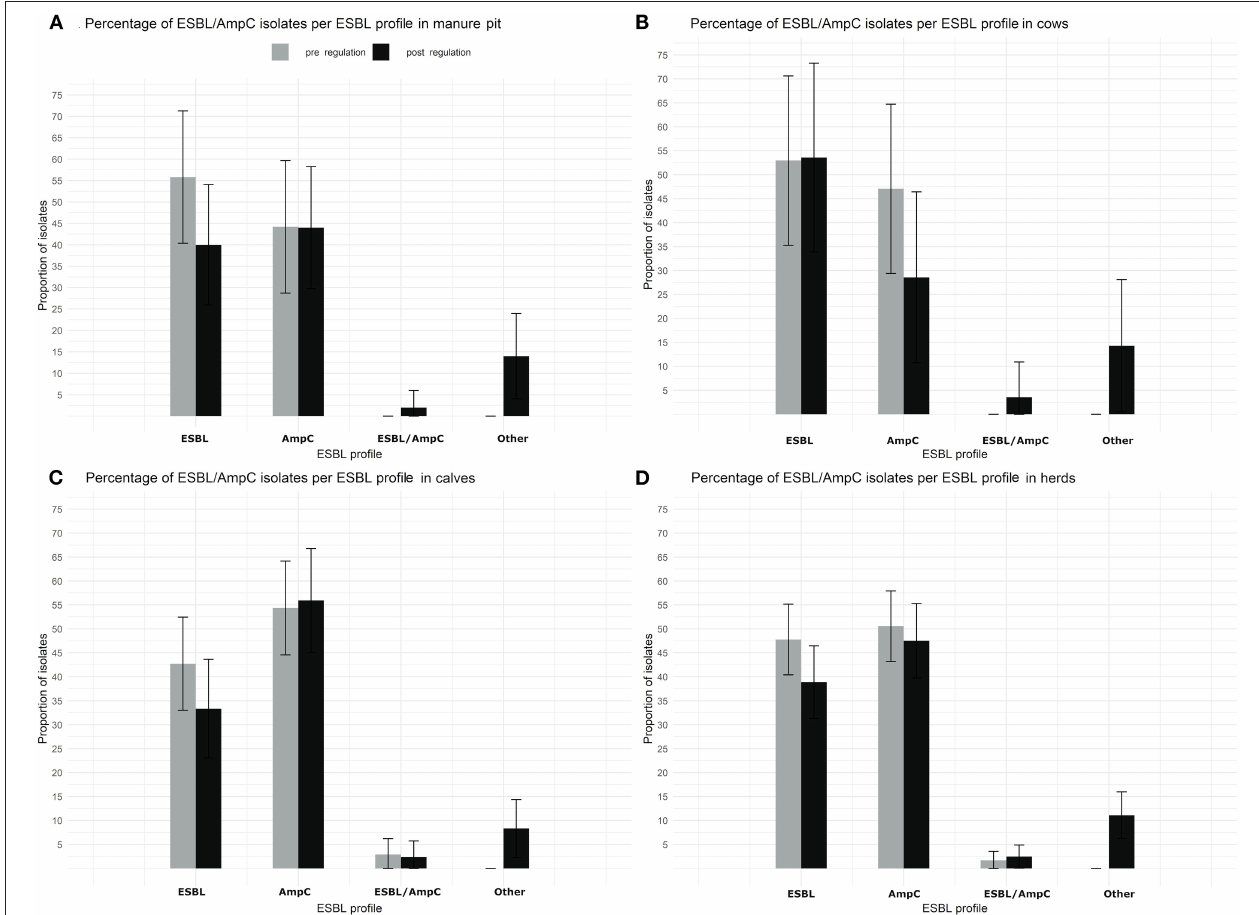
FIGURE 8 | Comparison of the proportion of isolates with a putative ESBL/AmpC Escherichia coli per ESBL profile and per sample type (manure pit, cows, calves, herd) from 87 dairy farms from Québec, Canada, pre (gray) and post (black) regulation implementation. (A) Percentage of ESBL/AmpC isolates per ESBL profil in manure Pit. (B) Percentage of ESBL/AmpC isolates per ESBL profil in cows. (C) Percentage of ESBL/AmpC isolates per ESBL profil in calves. (D) Percentage of ESBL/AmpC isolates per ESBL profil in